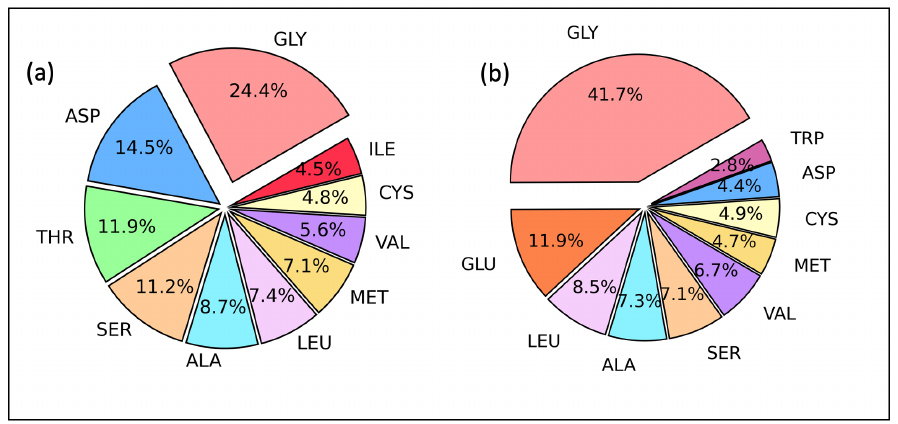
Figure 2. Ten most abundant amino acid residues acting as ( a ) donors and ( b ) acceptors in database A (in percentage). Database A includes ca. 12,000 experimental protein–ligand complexes and ca. 22000 protein–ligand hydrogen bonds with their geometries. Experimental PDB IDs for database A can be found in the supplementary Materials under the topic of PDB IDs for database